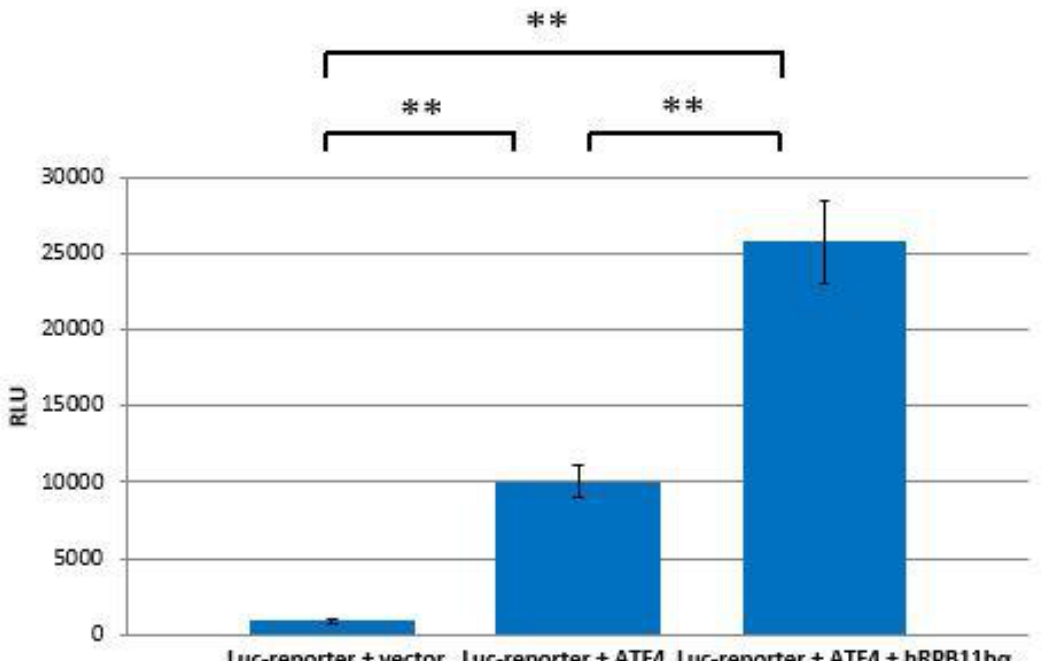
Figure 4. hRPB11b α is involved in ATF4-mediated transcription. HeLa cells were transiently transfected with 0.2 µ g of the 3 × ATF4-Luc reporter and 1 µ g of the indicated expression vectors. Intensity of the light (560 nm) emitted as a result of the luciferase catalyzed chemiluminescent reaction is represented along the ordinate axis in relative light units (RLU = light emission / second). The data are presented as mean ± SD and representative of three independent experiments (** p < 0.005 for both measurements) performed in duplicate after normalization for transfection e ffi